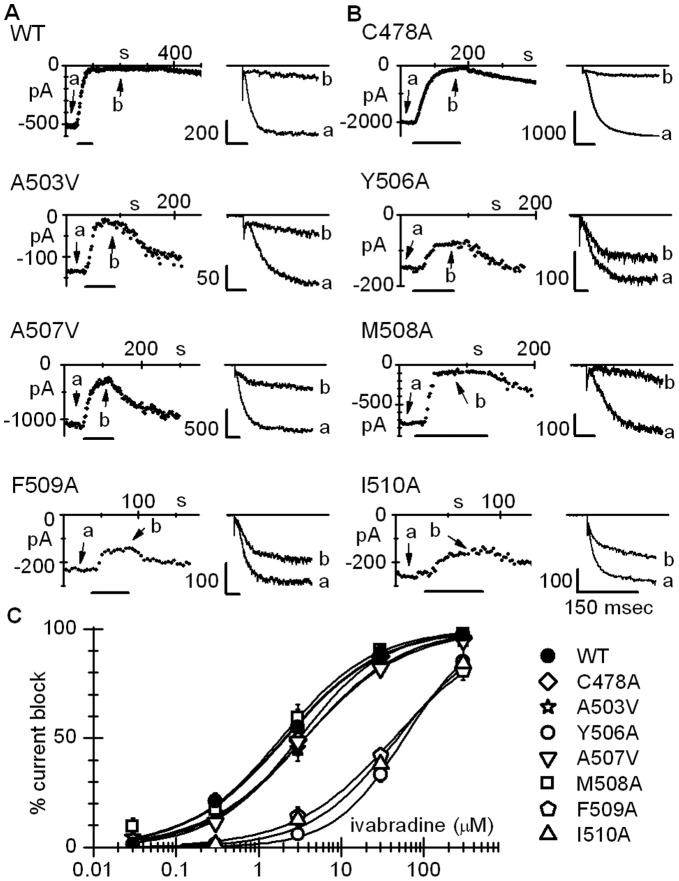
Ivabradine-induced block of WT and mutant hHCN4 channels.A,B: time-courses of current amplitudes (left panels) and sample current traces (right panels: a, control; b, steady-state block) recorded at −140 mV before, during, and after superfusion with 30 µM ivabradine (horizontal bars). Horizontal bars in right panels: 150 ms. C: Dose-response relations of ivabradine block of WT and mutant channels. Fitting with the Hill equation (curves) yielded half-block concentrations (IC50) of 2.1, 3.1, 3.6, 57.7, 3.7, 1.9, 44.0, 47.7 µM and Hill coefficients (nH) of 0.74, 0.84, 0.72, 1.02, 0.75, 0.77, 0.73, 0.83 for WT, C478A, A503V, Y506A, A507V, M508A, F509A, and I510A channels, respectively. Dose-response relations for Y506A, F509A, and I510A curves are significantly different from WT (P<0.05).